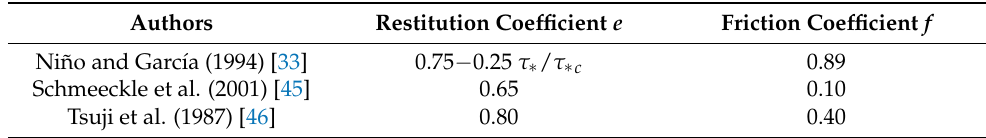
Table 2. Values for friction and restitution